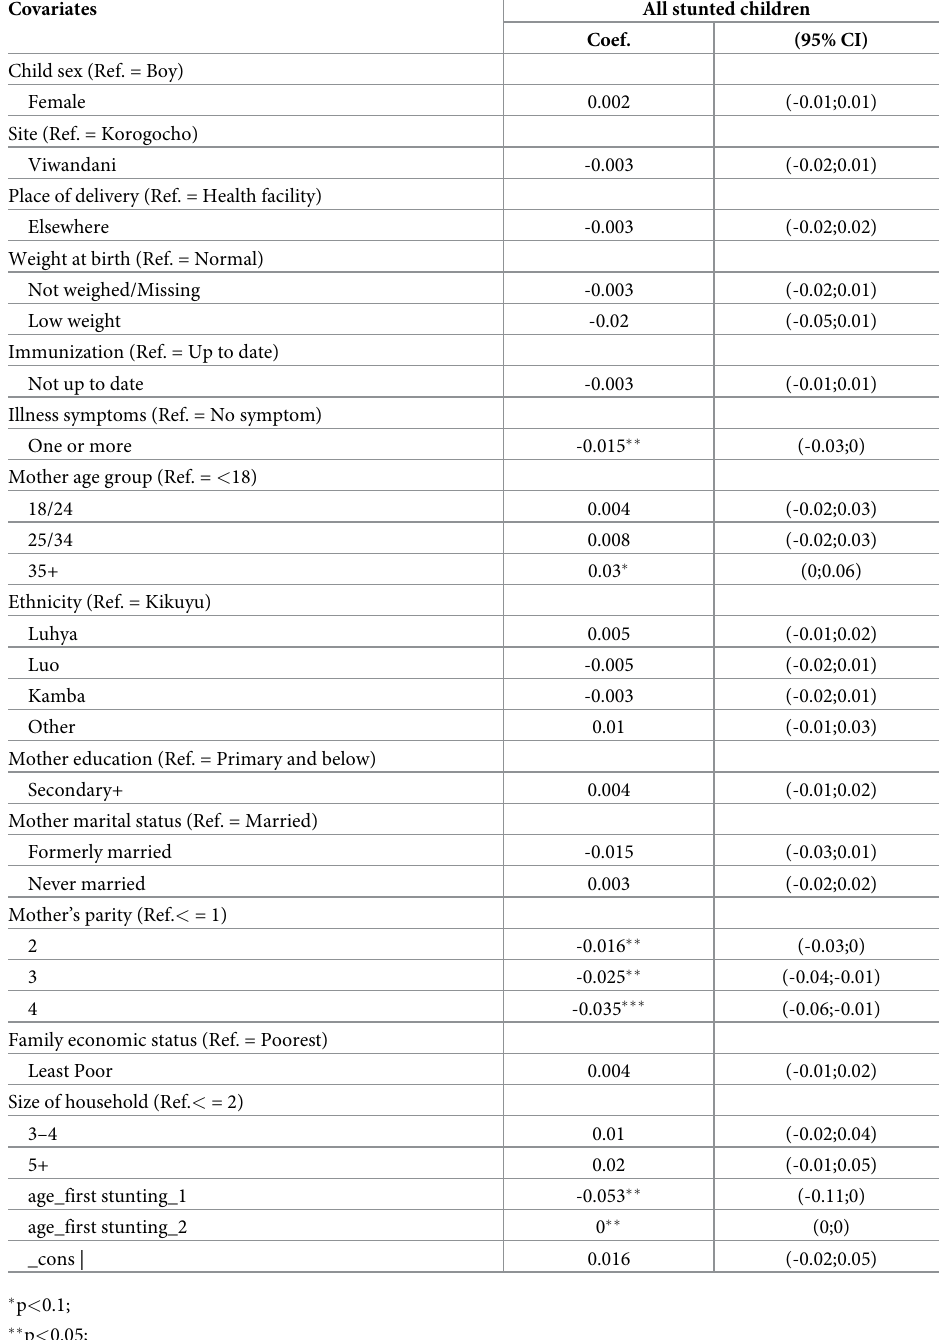
Table 4. Coefficients and 95% confidence interval from the linear regression of Δ HAZ on a second degree frac- tional polynomials in age of the child at first stunting.